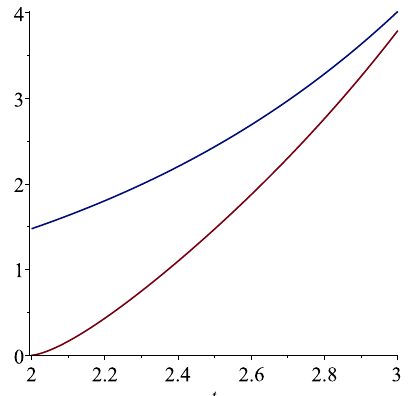
(cid:82) t (cid:82) u ( u − Γ ( 1 2 2 ) 2